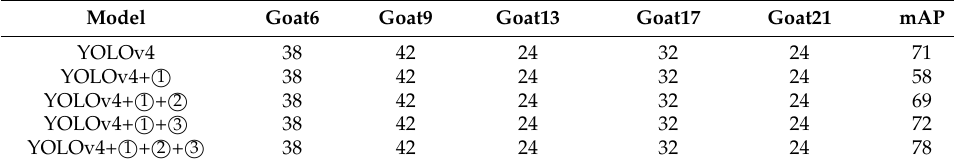
Table 2. Side-face-recognition results of goats with different side faces. Model Goat6 Goat9